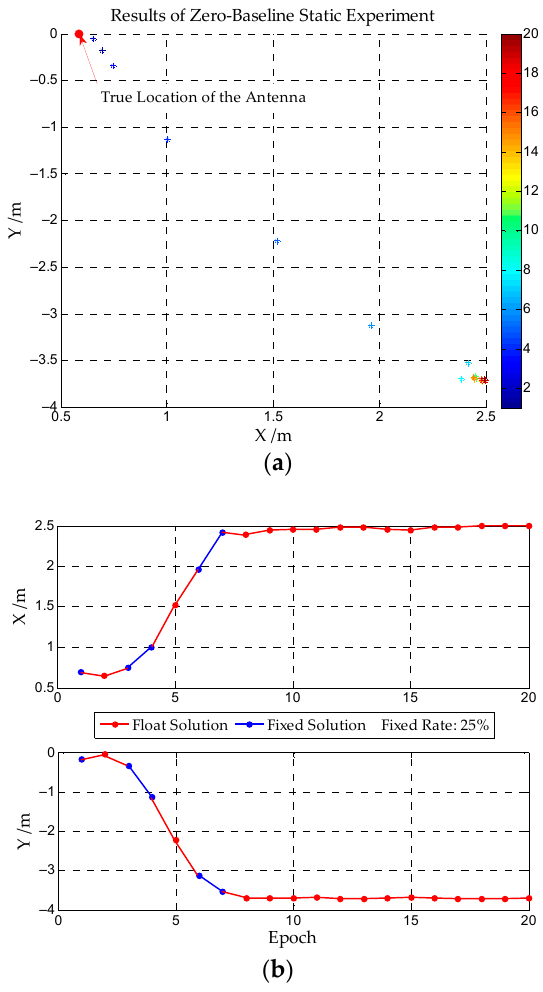
Figure 5. ( a ) Horizontal Positioning Results of Experiments 1, ( b ) Positioning Results on X, Y.